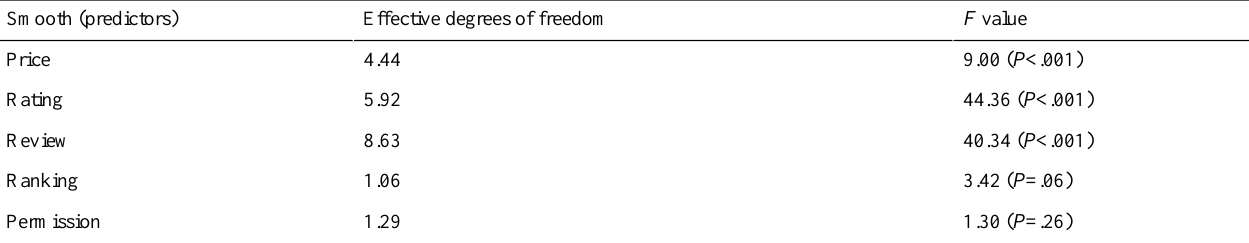
Table 4. Generalized additive model (GAM) of anxious app